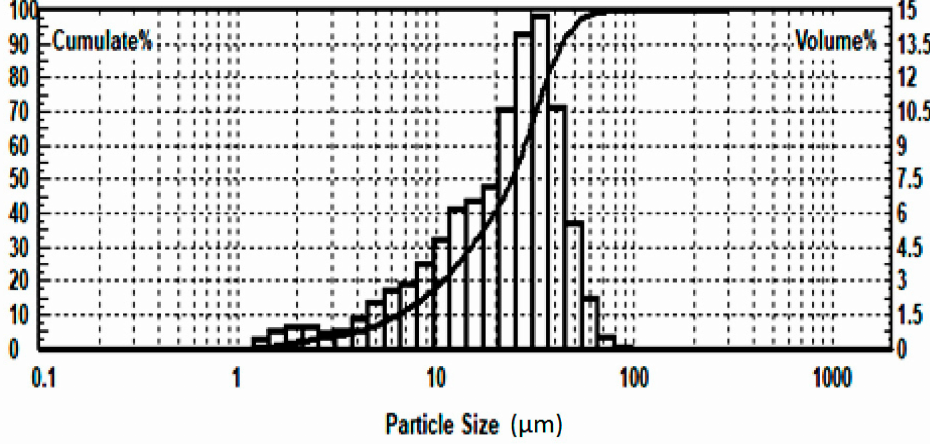
Figure 7. Distribution of particles in the combined collector agent without dispersion.